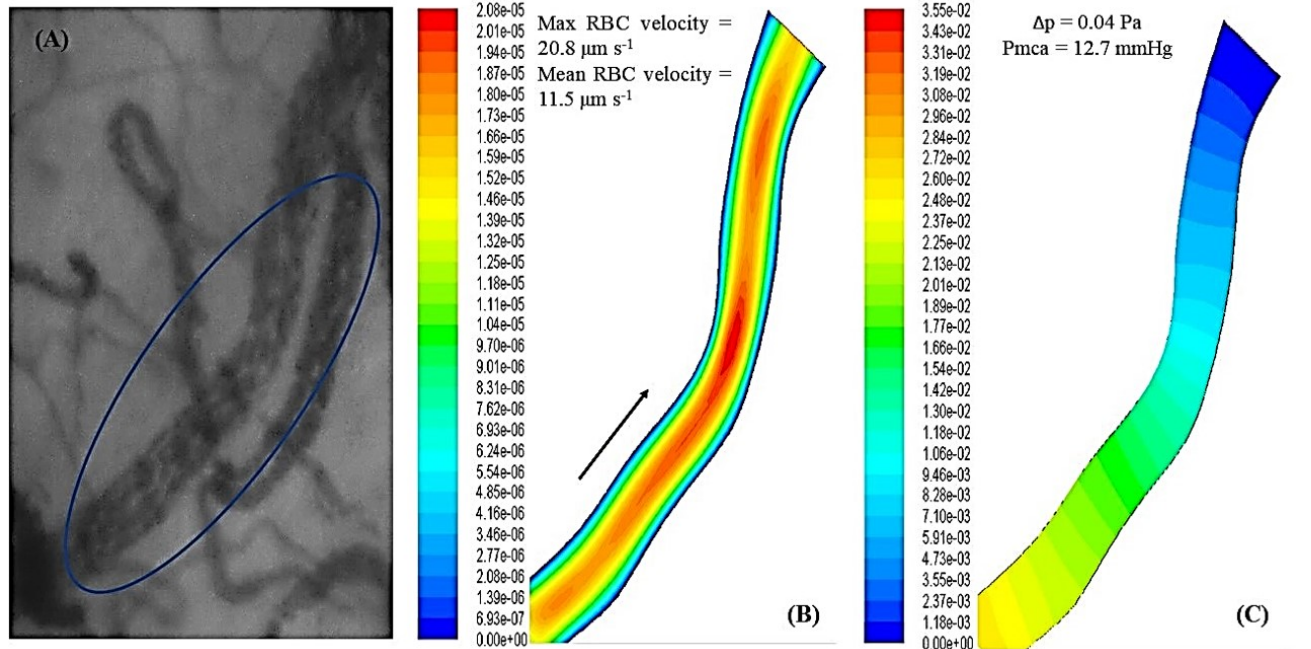
Figure 1. ( A ) is the reconstructed microvessel from a recorded sublingual microcirculation video; ( B ) is the obtained flow field after application of computational fluid dynamics (the arrow shows the flow direction); and ( C ) is the obtained pressure field after application of computational fluid dynamics for the specific microvessel.